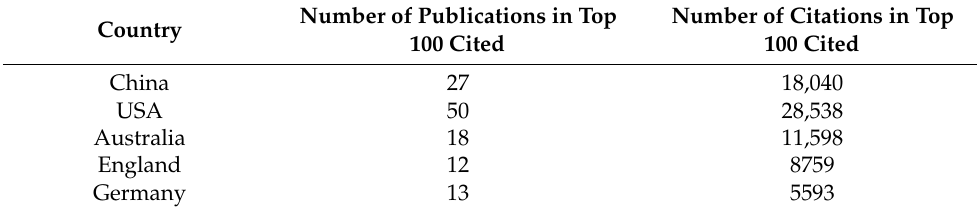
Table 6. Top five countries with highest